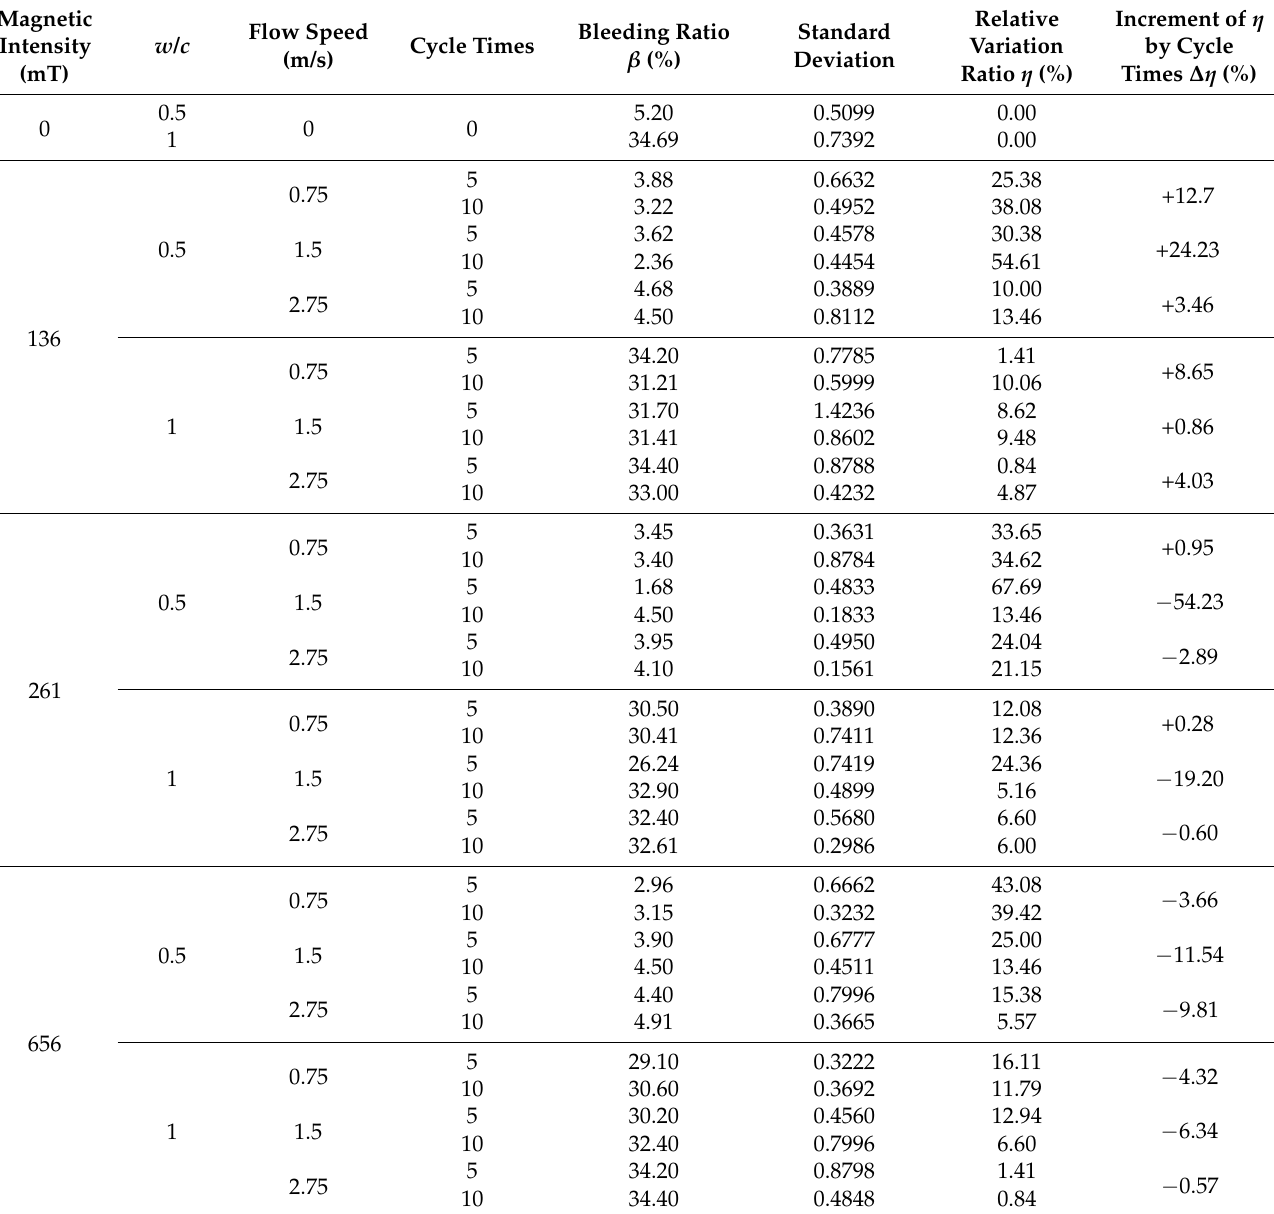
Table 5. The statistical result of test